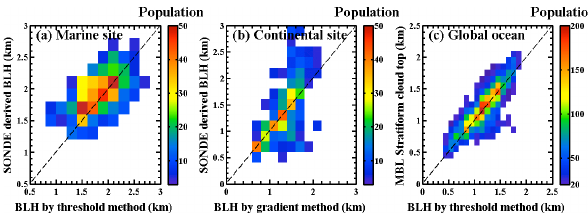
Figure 6. Comparison of BLHs between SONDE derived and MPL derived (a) with the threshold method at the marine site and (b) with the gradient method at the continental site; Comparison between marine BLH derived with the threshold method and marine boundary layer stratiform cloud top over the global ocean from CALIPSO measurements (c) .